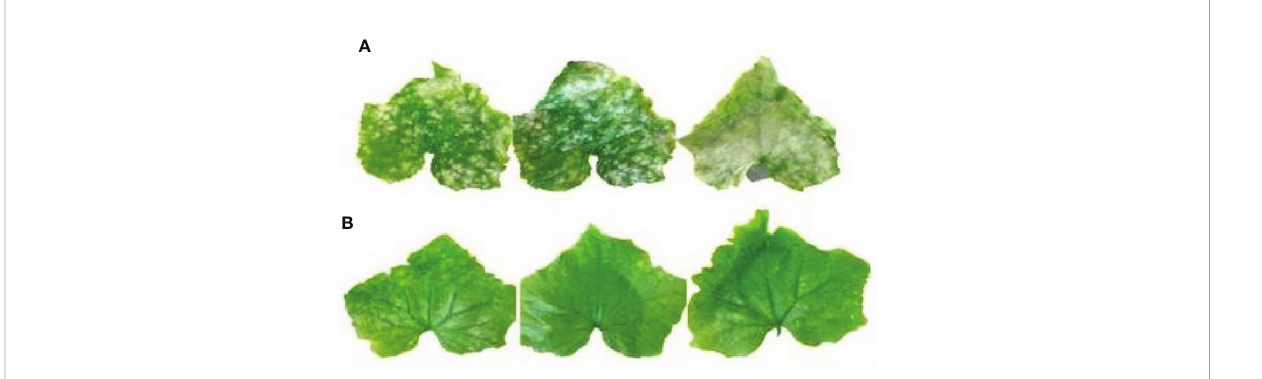
FIGURE 4 Ef fi cacy of microbiological agents, L. attenuatum on cucumber leaves arti fi cially infected with powdery mildew. (A) leaves treated with 0.05% tween 80 solution (control) after 20 days of the treatment, and (B) leaves treated with L. attenuatum after 20 days. Both treatments were applied 48 hours before the inoculation of P. xanthii . Other pictorial presentation showing a comparisons of TVI and IFR-treated leaves can be found in the Figure 1 of the supplementary material.